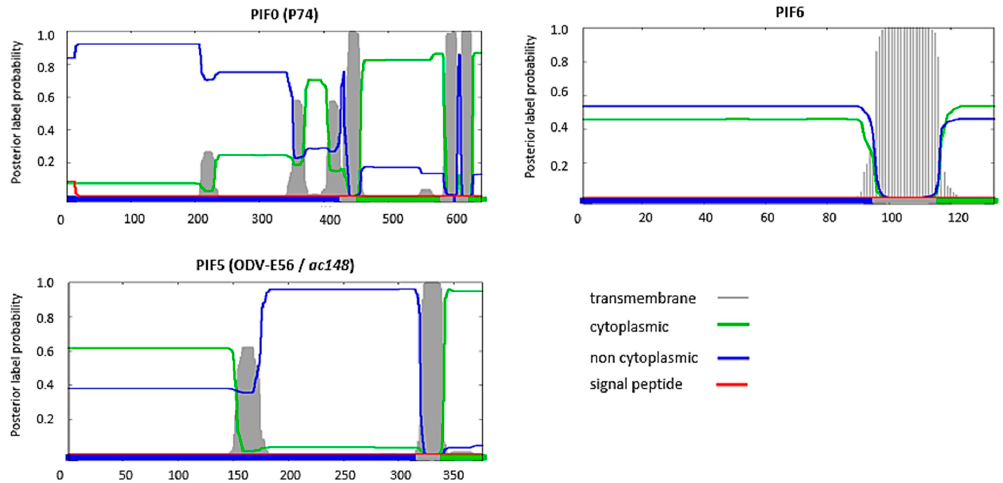
Figure 3. Prediction of the presence of transmembrane domains and signal peptides in PIF0, PIF5 and PIF6 and orientation of these proteins in an infected host-cell with the Phobius algorithm [17]. On the y -axis: the probability for the presence of transmembrane domains (grey), cytoplasmic (green) or non-cytoplasmic (blue) orientation of the amino acid sequence and presence of a signal peptide (red). The final result of the prediction is summarized by the bar at the bottom with the indicated colours. The x -axis shows the number of the amino acids of that specific sequence.